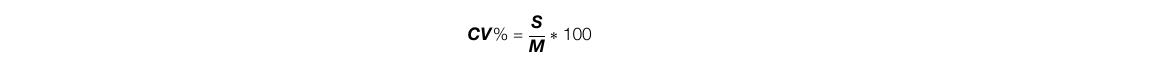
FIGURE2| Importanceandin fl uenceofthecoef fi cientofvariation(CV%).Thedimensionlessandunitlesscoef fi cientofvariationCV%isoftenpreferredtostandard deviation (S) as it is more convenient to describe data spreading regarding a measurement. Indeed, CV%s values are interesting ones as they can be used easily to compare variations of two or more quantitative datasets. Low CV%s, as compared to high ones, allows detecting signi fi cant tiny